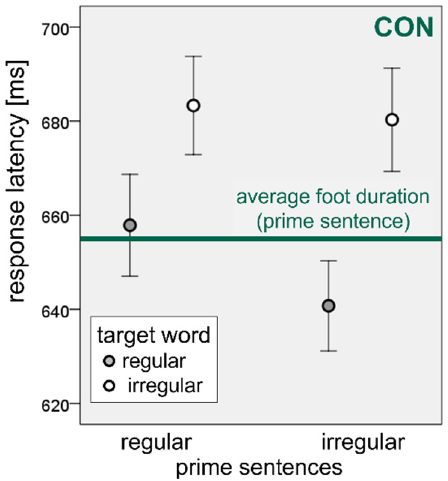
Figure 2. Response latencies (in milliseconds) of the neurotypical participants/CON (mean values, 95% CI of the mean), as a function of the regularity of the prime sentences (abscissa) and the target words (filled and unfilled symbols). The horizontal line represents the grand average of the mean foot durations across all prime sentences.